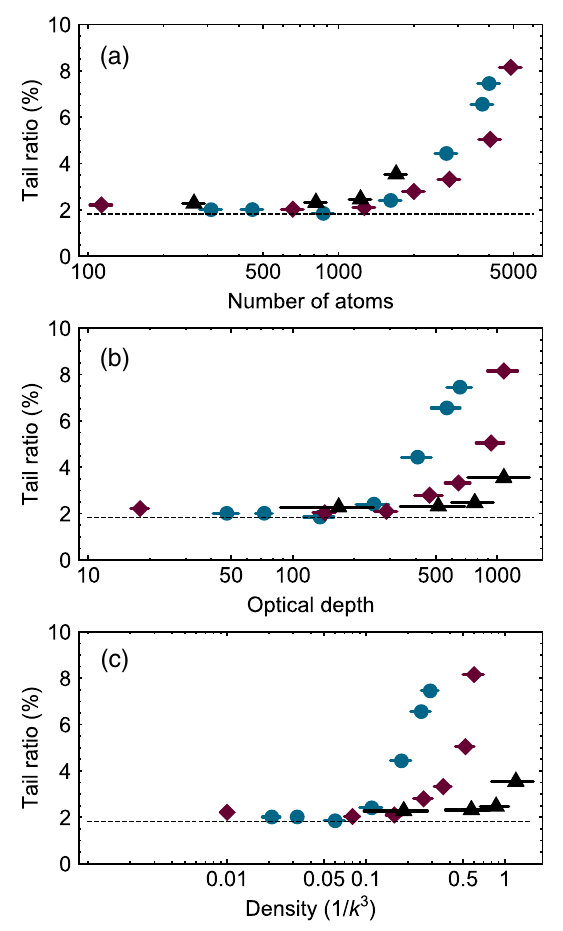
FIG. 9. Tail ratio as defined by Eq. (F) for the same data sets as used to extract the decay times in Fig. 2 ( s ≃ 27